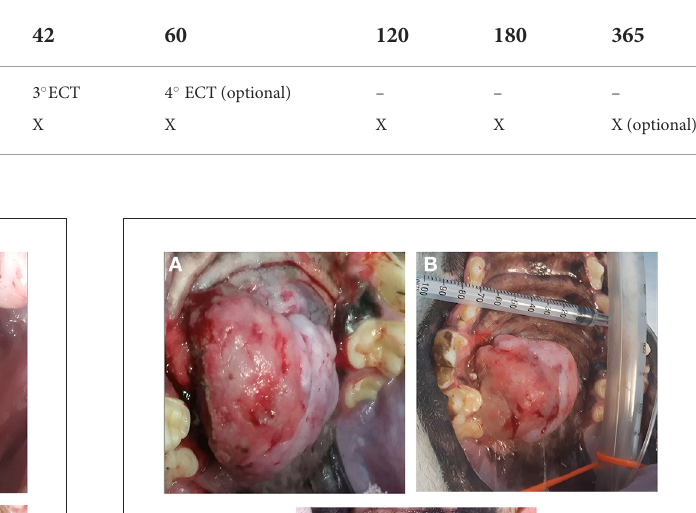
TABLE 2 scheduling of follow-ups and ECT sessions.